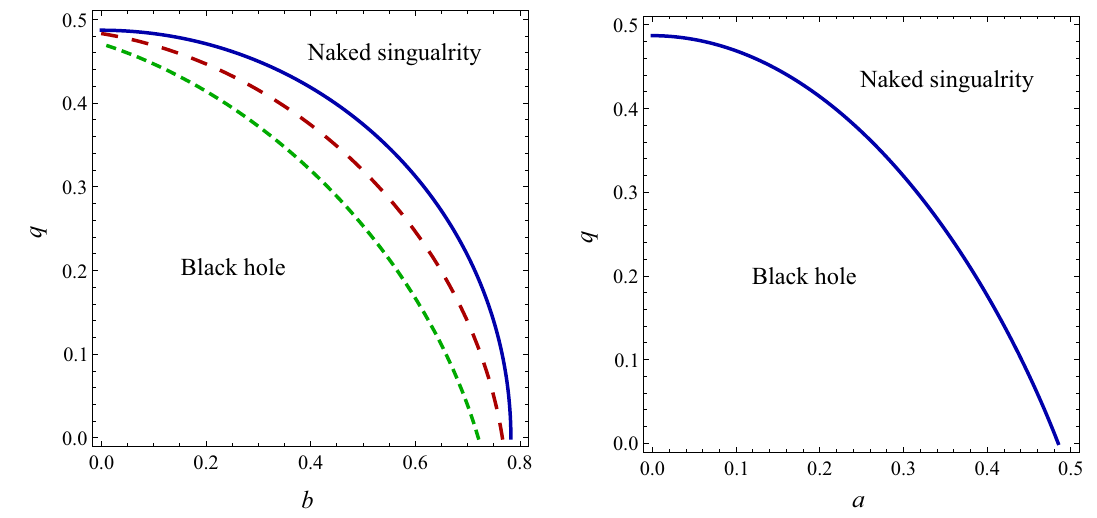
Fig. 1 Plot showing the dependence of charge q with spin a , b . (Left) For a (cid:7)= b , a = 0 (blue solid line), a = 0 . 1 (red dashed line), a = 0 . 2 (green dashed line). (Right) For a = b